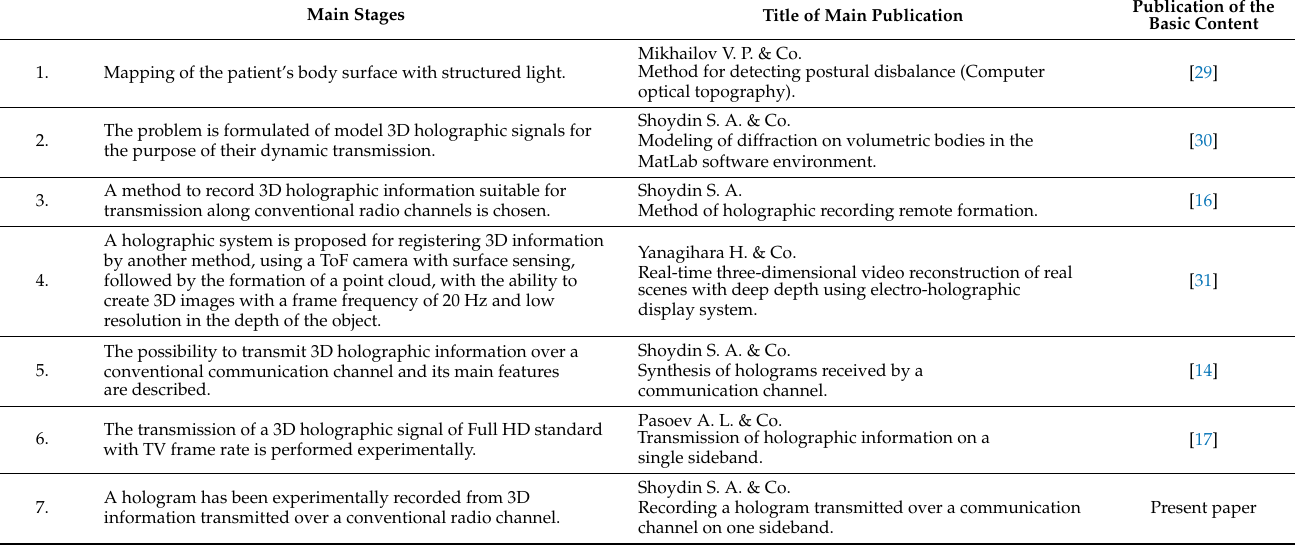
Table 1. The main stages that we relied